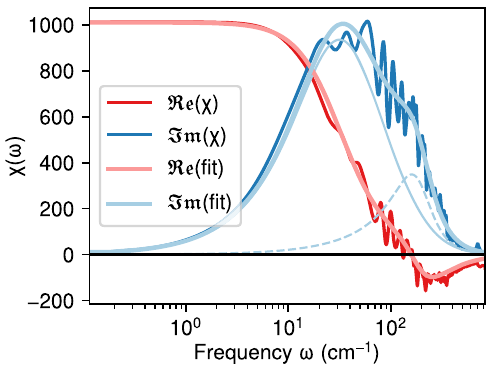
Fig. 8 Frequency-dependent dielectric response of cubic BaTiO 3 at 250 K computed with a 6 × 6 × 6 supercell. The imaginary part of the spectrum is fi tted to a sum of two simple harmonic oscillator response functions, as in ref. 25 ; the two separate oscillator responses are shown in thin light blue lines, while the fi tted sum is shown as a thick light blue